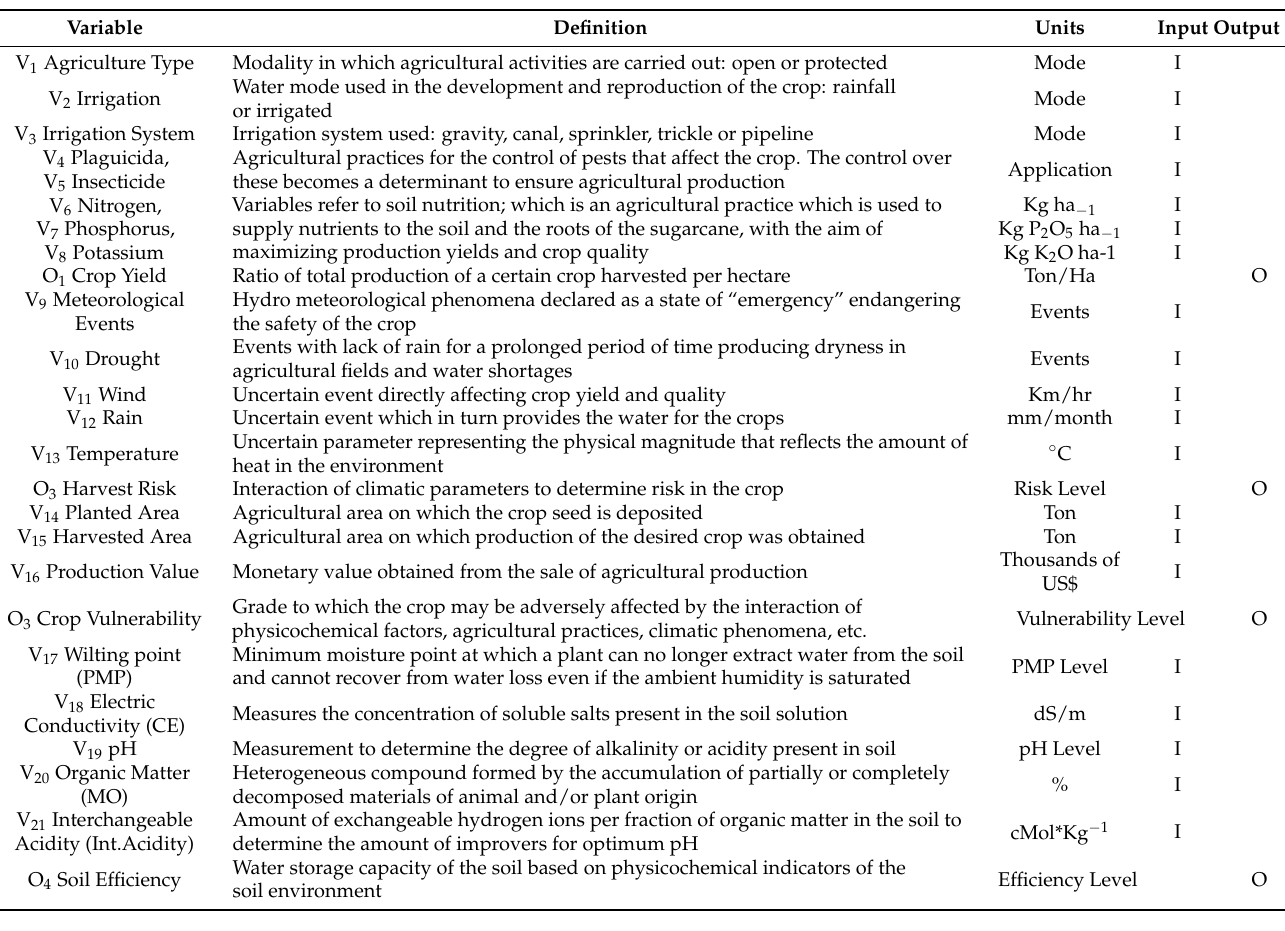
Table 4. Variables of sugar cane